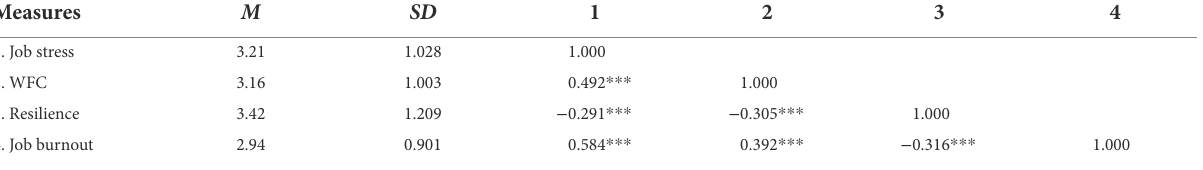
TABLE 1 Descriptive statistics and correlation among variables.